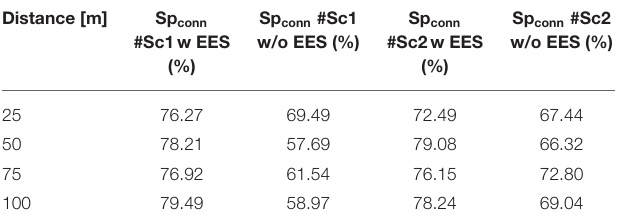
TABLE 3 | Rate of exploited connections among buildings for the different